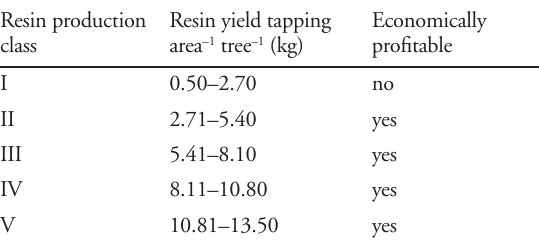
Table 2. Classification of experimental trees into five resin-pro- duction classes. Resin production class